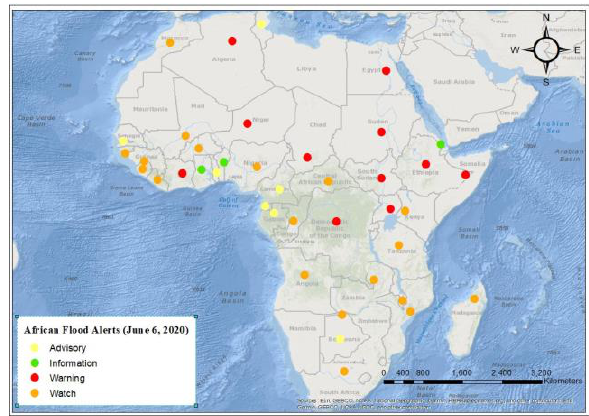
Figure 3. African countries with flood alert on 6 th June 2020 SAR output: Figures 4 and 5 show the binary classified image north of Lukolela, the town of the Democratic Republic of the Congo using SAR imagery. The common classifications that allow differentiating between flooded areas vs permanent water bodies are not used in these images. However, a series of outputs comprising water bodies and areas with standing water were created throughout the flood event to determine the flood extent using the change detection approach.